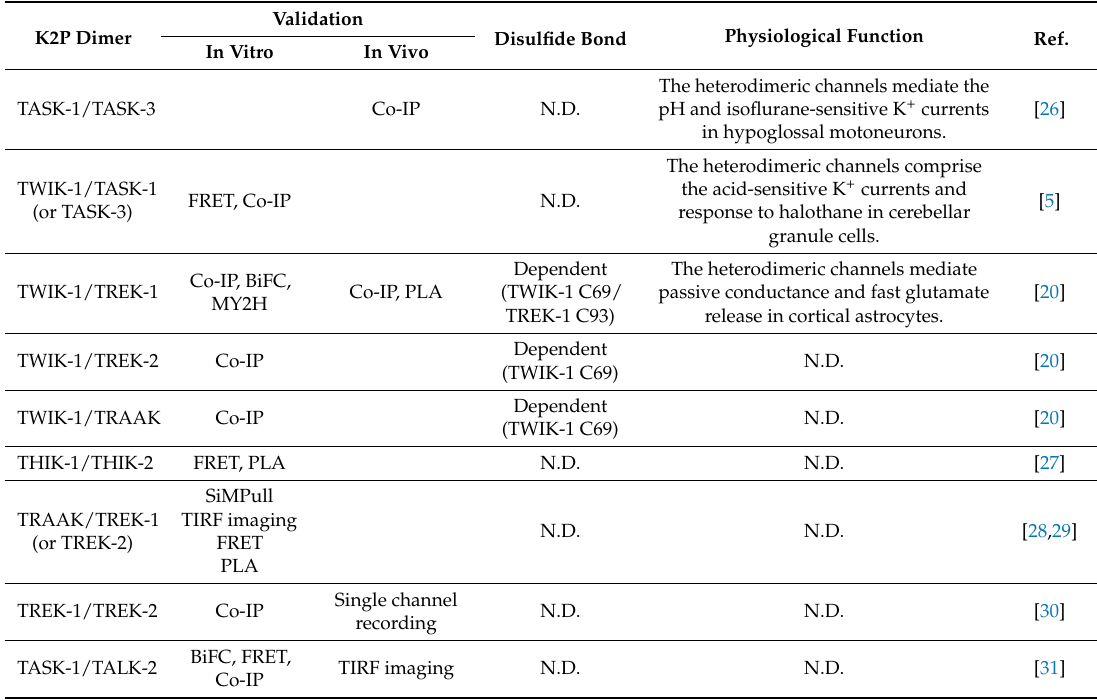
Table 1. Heterodimers of two-pore domain potassium (K2P)